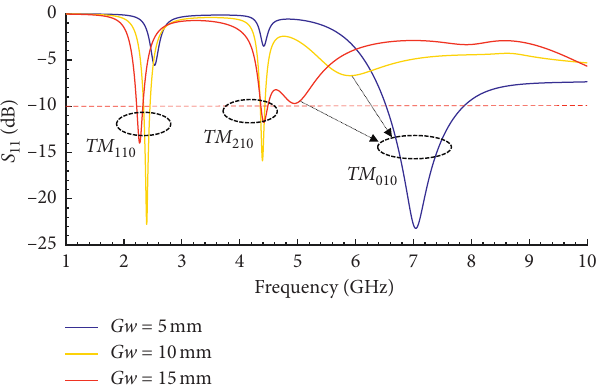
Figure 16: S BioAs-MPA.